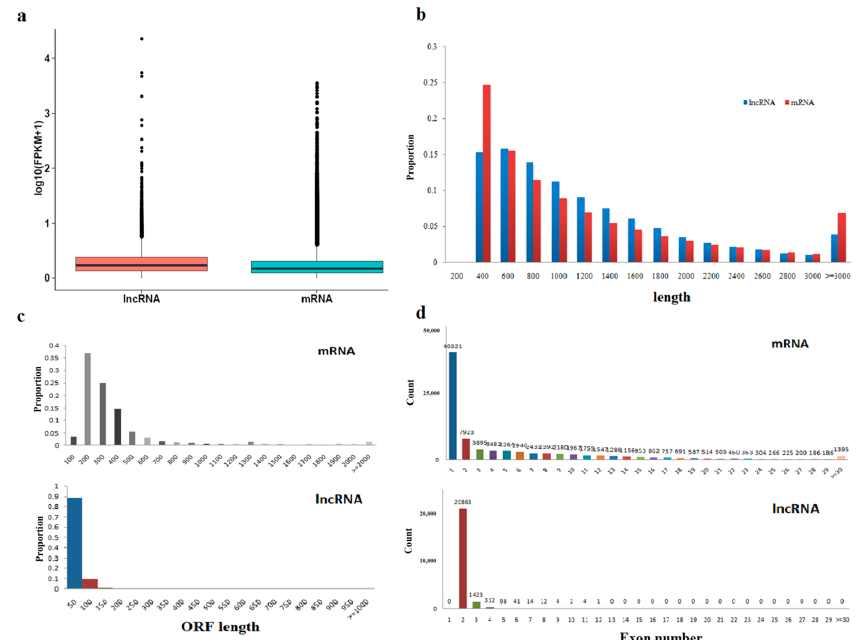
Figure 3. Comparison of the identified lncRNAs and mRNAs. ( a ) Expression level analysis of the mRNAs and lncRNAs. ( b ) The length distribution of lncRNAs and mRNAs. The abscissa represents length, and the ordinate is the number of RNA with length in this range. ( c ) Distribution of open reading frame lengths (ORF) in the mRNAs and lncRNAs. The abscissa represents ORF length, and the ordinate is exon numbers distributed in the range of RNA numbers. ( d ) Exon number distribution of lncRNAs and coding transcripts, the abscissa is exon numbers, and the ordinate is exon numbers distributed in the range of RNA